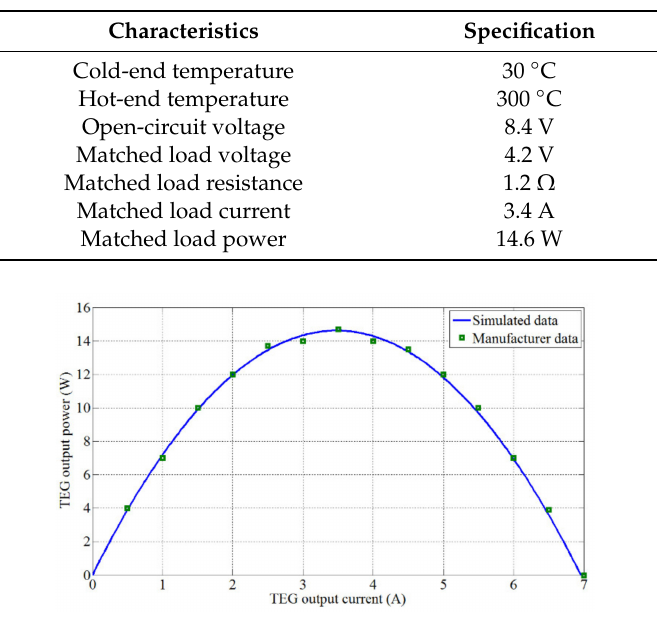
Figure 3. TEG1-12611-6.0 output power against the output